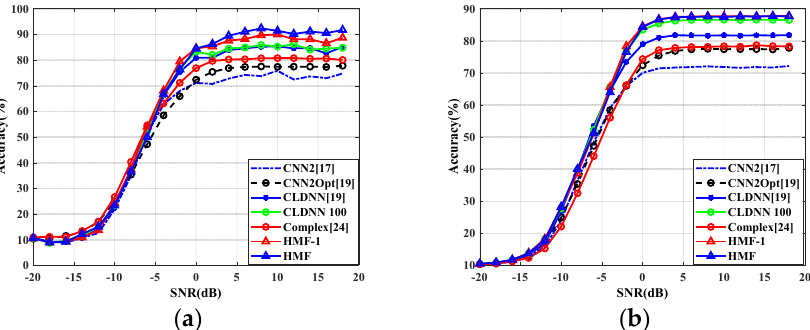
Figure 9. Classification accuracy comparison with state-of-the-art methods at different SNRs on ( a ) RadioML2016.10a and ( b ) RadioML2016.10b.